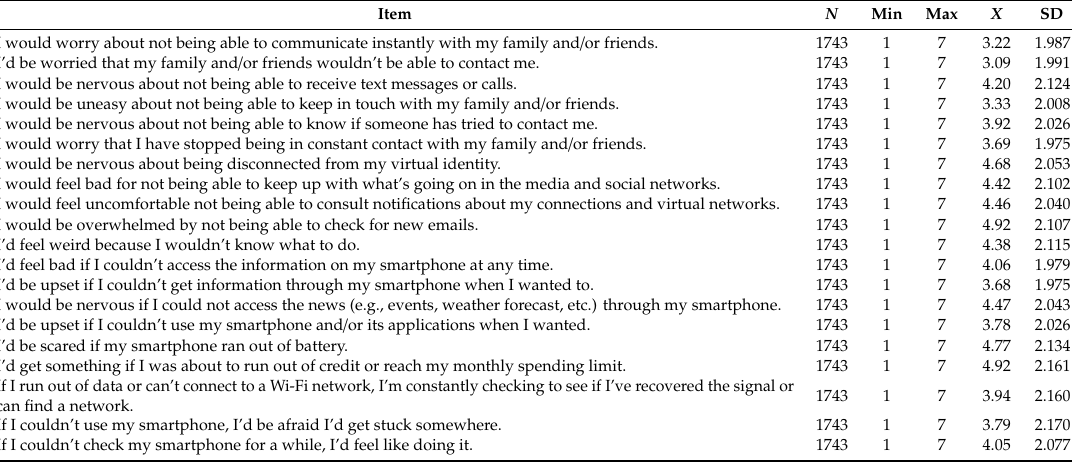
Table 1. Descriptive analysis.